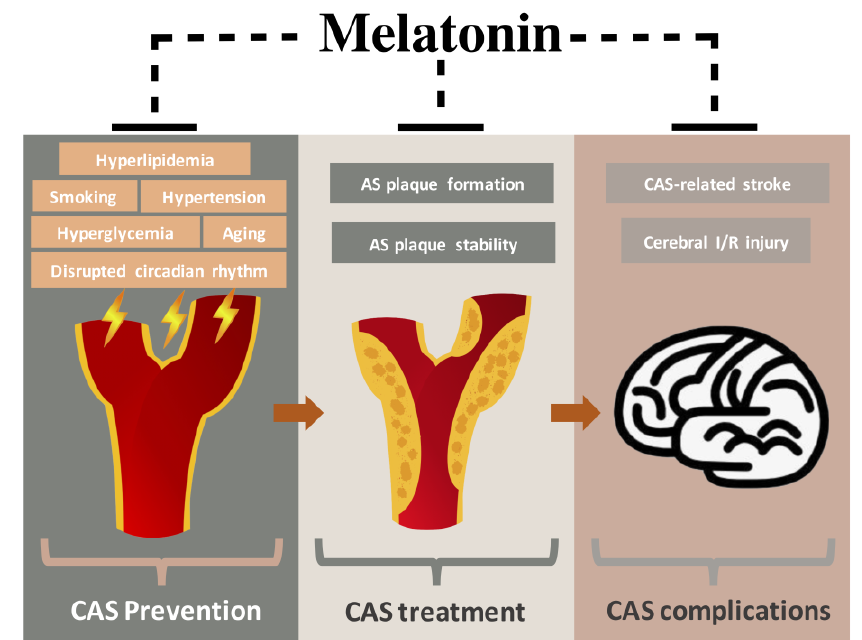
Figure 2. Illustration of the potential preventive and therapeutic properties of melatonin in atherosclerotic carotid artery stenosis. AS, atherosclerosis; CAS, carotid artery stenosis; I/R, is-